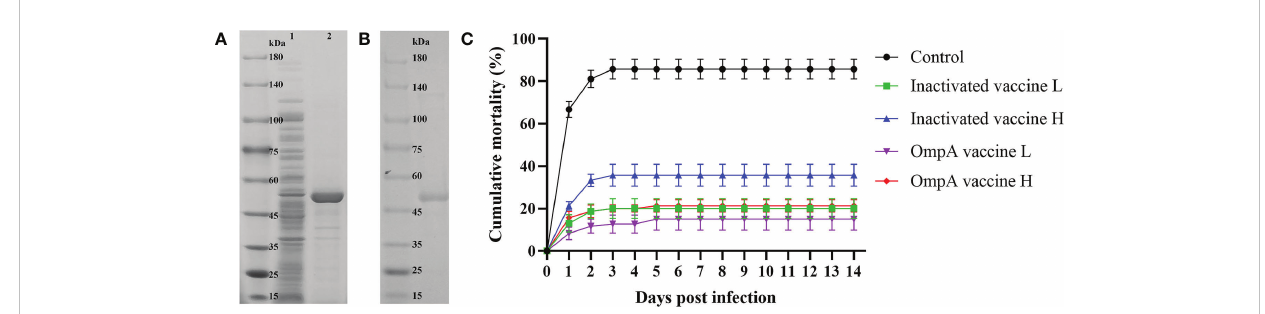
FIGURE 1 Preparation of recombinant OmpA protein and cumulative mortality. (A) SDS-PAGE analysis of the induced recombinant OmpA protein. Lane 1: total proteins of the uninduced E coli BL21 (DE3) competent cells that transformed with pET-32a-OmpA, Lane 2: total proteins of the induced E coli BL21 (DE3) competent cells that transformed with pET-32a-OmpA. (B) SDS-PAGE analysis of the puri fi ed recombinant OmpA protein. (C) Inactivated and OmpA subunit vaccines decreased the mortality of juvenile M. amblycephala post A hydrophila infection. Signi fi cant differences were found between the vaccinated groups and the control group ( P <